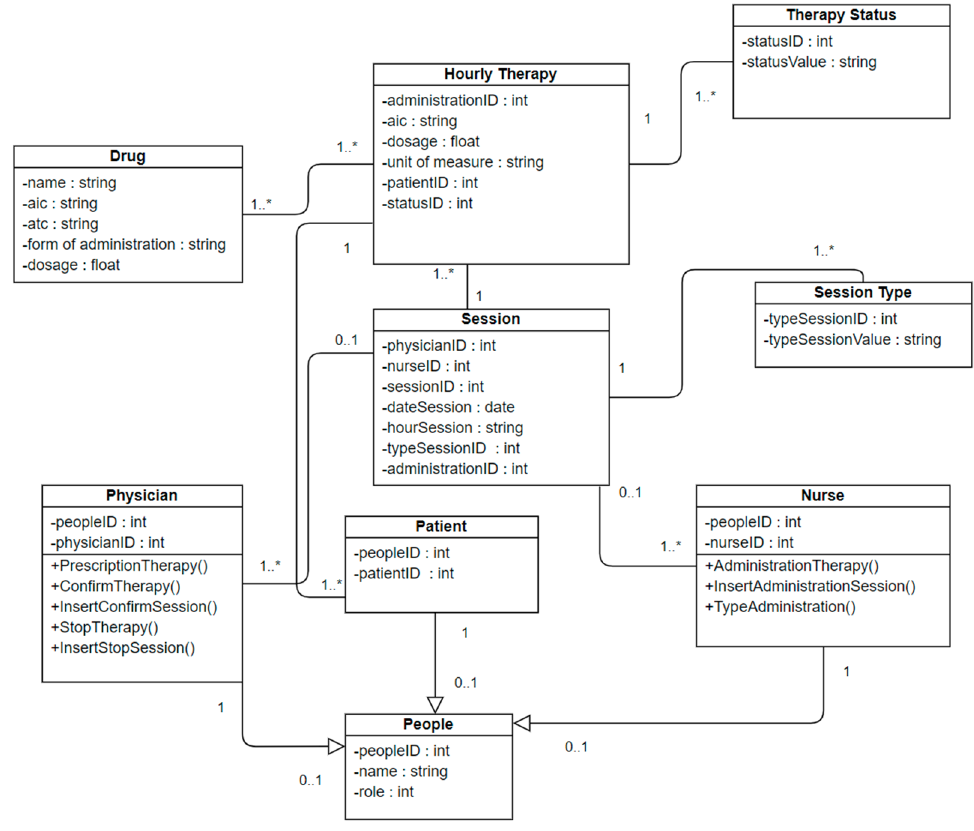
Figure 3. Therapy administration class diagram.